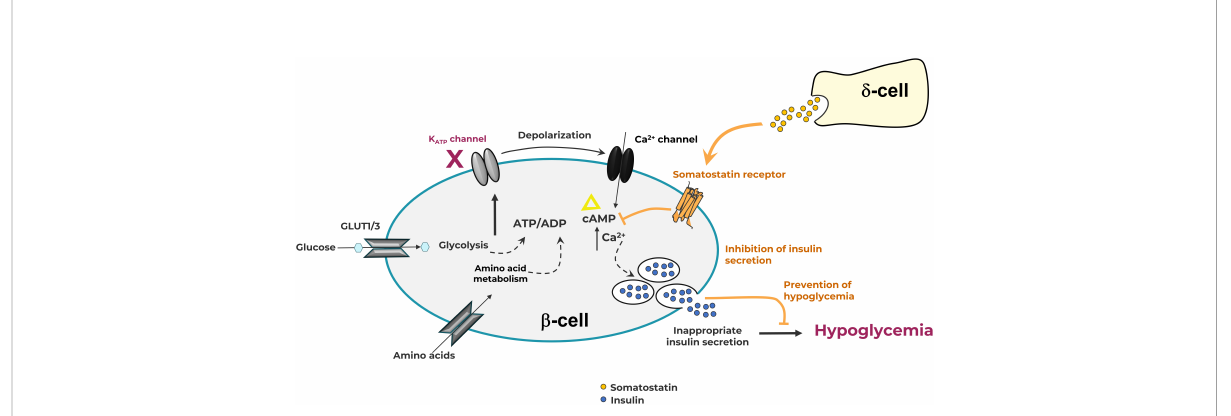
FIGURE 2 The pancreatic b -cell in Congenital Hyperinsulinism showing somatostatin action through G-protein coupled somatostatin receptors on the cell membrane. Elevation of intracellular ATP level drives K-ATP channel closure, membrane depolarization, and subsequent in fl ux of Ca ++ ions. Increases in intracellular Ca ++ and cAMP levels lead to the release of insulin. Somatostatin receptor activation induces the formation of G i -GTP, which inhibits adenylate cyclase, preventing the formation of cAMP, thus reducing insulin